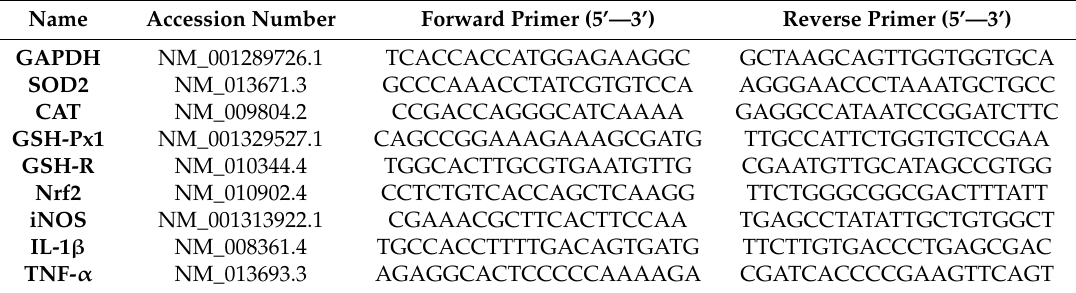
Table 1. Primer sequences of genes analyzed in real time